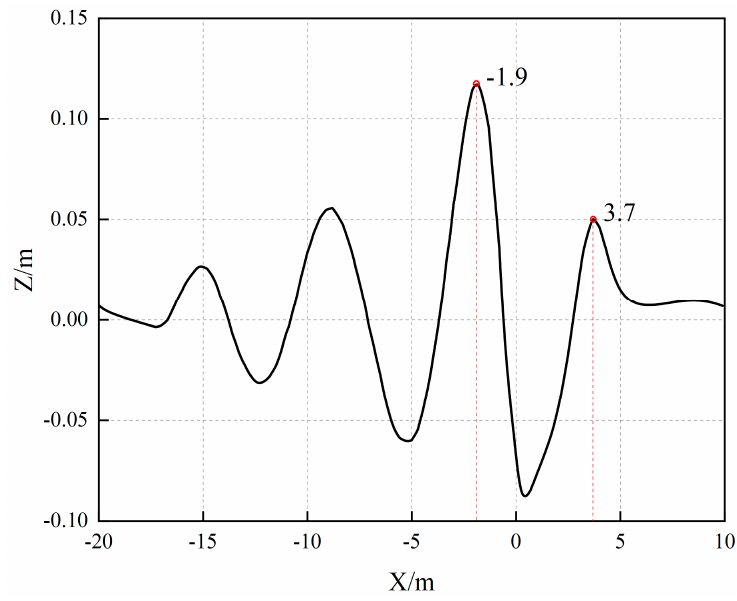
Figure 4. Longitudinal section wave cut diagram of direct flight.